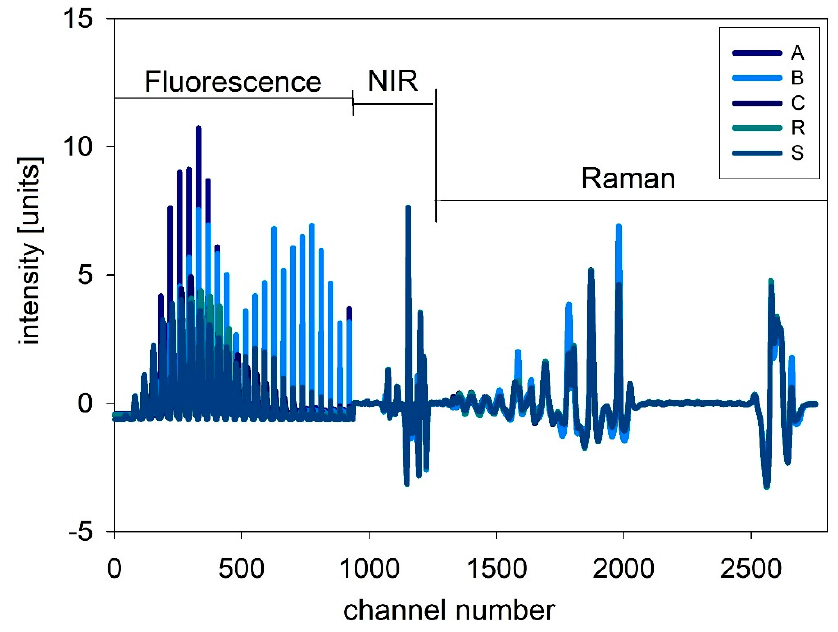
Figure 4. Combination of all spectra for evaluation.